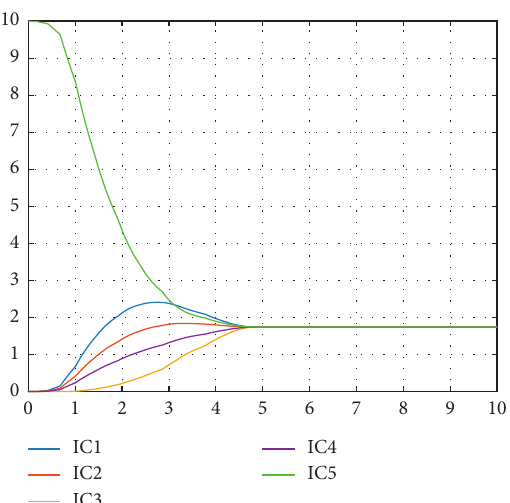
Figure 9: Total power demand of generator with power generation i with power gen-